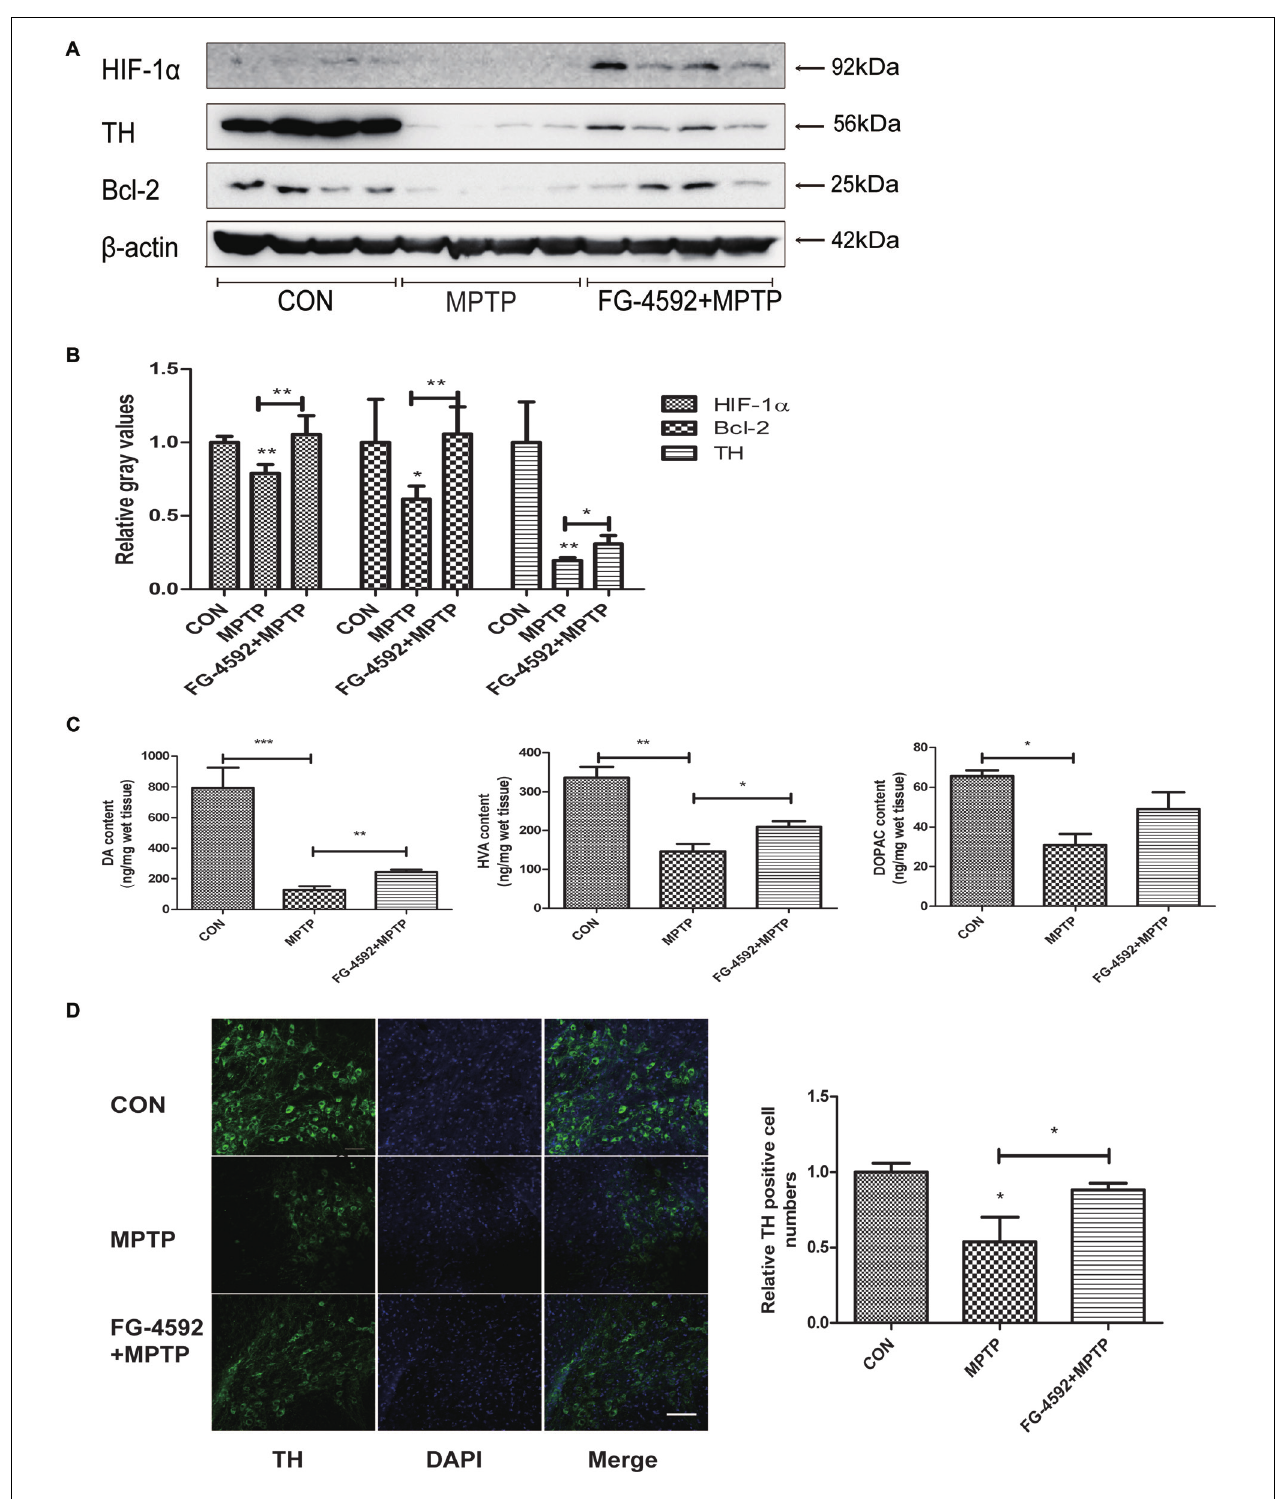
FIGURE 7 | FG-4592 rescued the depletion of DA and TH protein in the striatum, and the loss of TH positive neurons in the substantia nigral induced by MPTP. Western blotting analysis and quantification of relative TH, HIF-1 α and Bcl-2 protein abundance in the striatum (A,B) . β -protein served as the internal control. The levels of DA, DOPAC, and HVA (C) were calculated and expressed as nomogram per milligram wet tissue weight. Immunofluorescence images of TH (green) were taken in the SN. Nuclei were revealed by DAPI staining (blue), with the merged images depicted at the right (D) . Scale bars: 100 µ m. Data were expressed as mean ± SD ( n = 5). ∗ P < 0.05, ∗∗ P < 0.01, ∗∗∗ P < 0.001 as compared to the control or MPTP treated